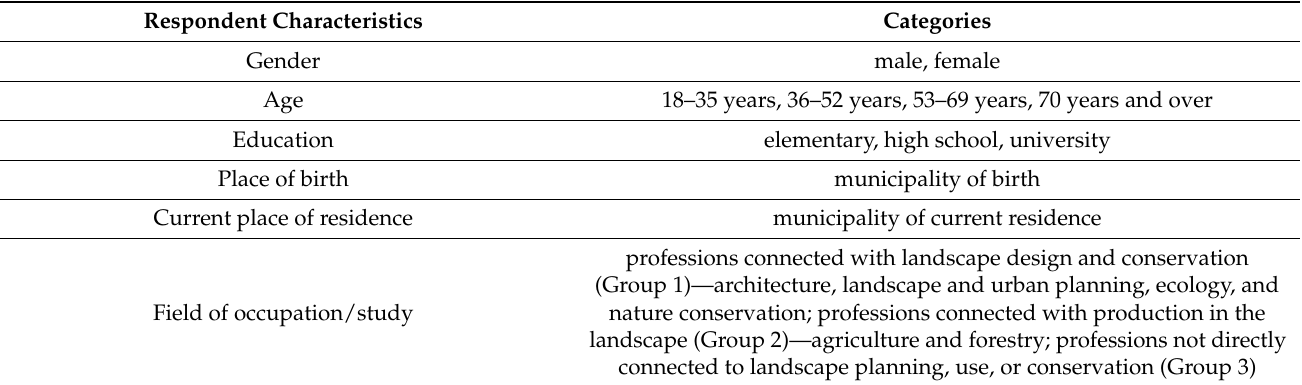
Table 1. Characteristics of respondents and their categories contained in the